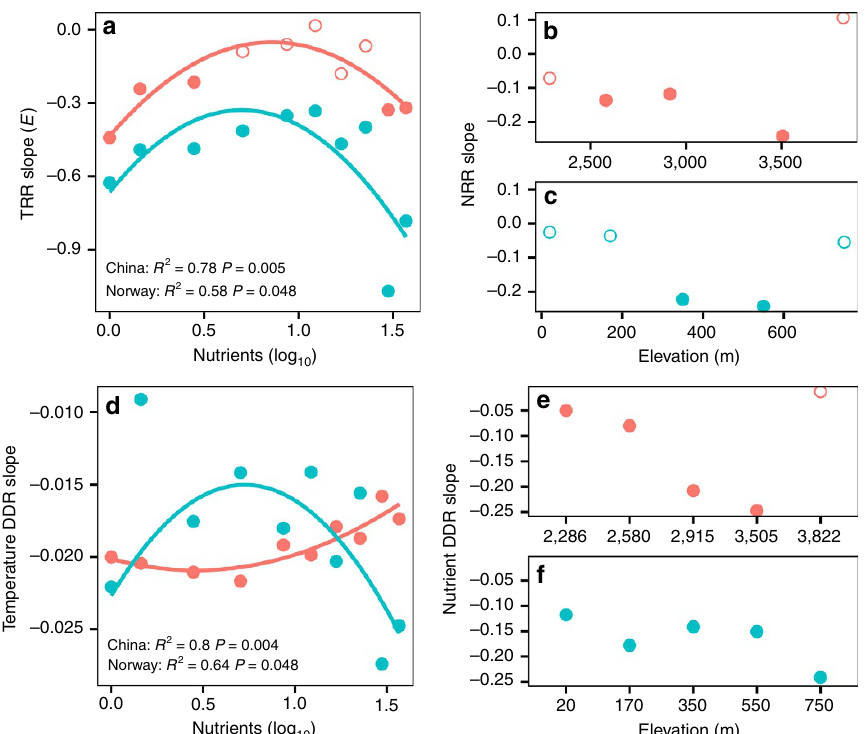
Figure 3 | The variation of the temperature or nutrient dependence of biodiversity. Species richness plots ( a – c ): the slopes of the TRR and NRR along nutrient enrichment ( a ) and elevation gradients ( b , c ), respectively. The TRR slope ( a ), characterizing the temperature dependence of species richness, was calculated according to MTE 1 , and log-transformed bacterial species richness is a linear function of the inverse absolute temperature (log 10 ( S ) p E (cid:2) (1/ kT ), where S is species richness, k is Boltzman’s constant 8.62 (cid:2) 10 (cid:3) 5 eV K (cid:3) 1 , T is absolute temperature in Kelvin and E is the slope or ‘activation energy’ ( e ) in eV. Community similarity plots ( d – f ): The slopes of the temperature DDR and nutrient DDR along nutrient enrichment ( d ) and elevation gradients ( e , f ), respectively. DDR was based on Sørensen similarity. The nutrient DDR slopes were multiplied by 100 for better visualization. Solid dots indicate the significant ( P o 0.05) relationships. Initially added NO 3 (cid:3) (mg N l (cid:3) 1 ) represents the nutrient enrichment. Blue and red dots represent Norway and China,